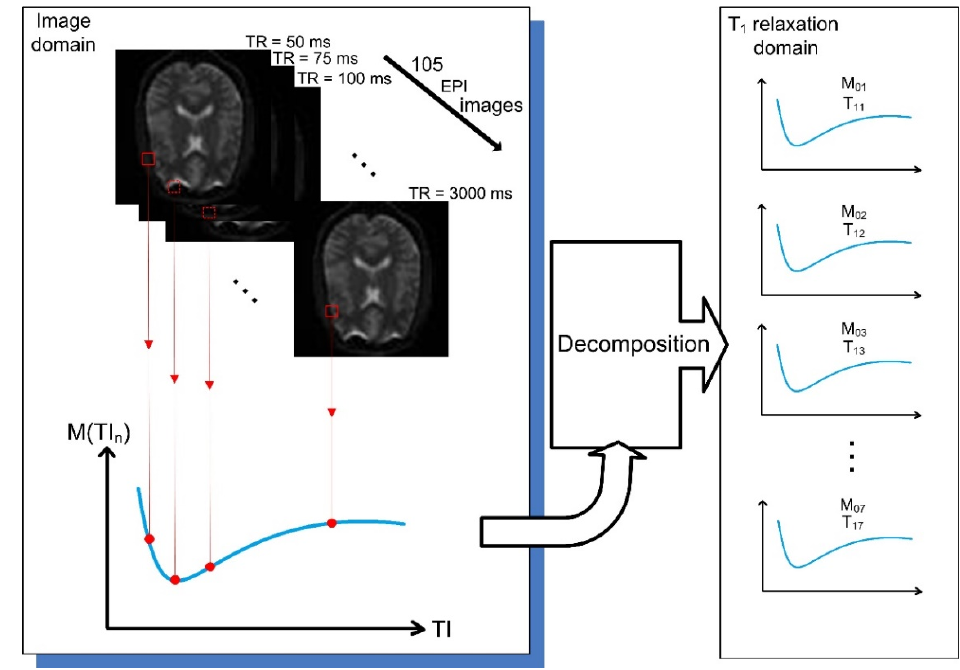
Figure 1. Illustration of the data acquisition approach proposed by Lifshits et al. [18]. The experi- mental data consist of a series of EPI images with different times of inversion. A one-dimensional signal is constructed for every image voxel, dependent on the TI time. The signal is then decomposed into several curves, each representing a voxel component with specific values of M 0 and T 1 . In this way, a cortical composition of a single voxel series can be decomposed into multiple signals in the T 1 relaxation domain.